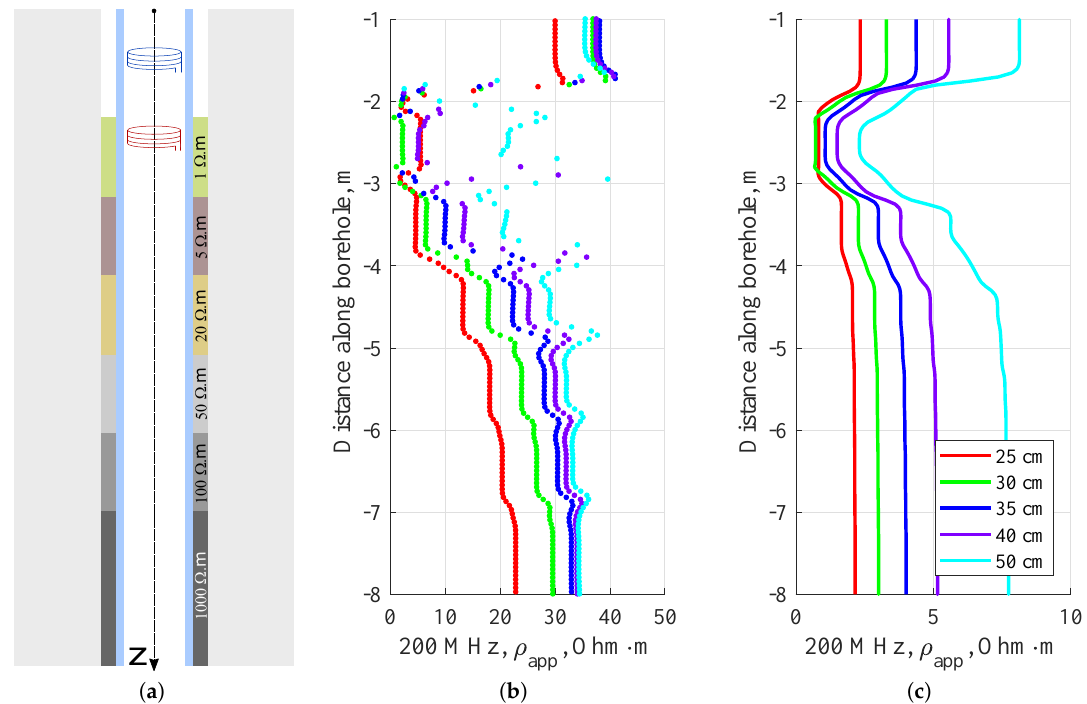
Figure 11. ( a ) The wellbore model with different resistivities of the cement (different solidification states) and apparent resistivity at the frequency of 200 MHz calculated from ( b ) signal phase and ( c ) amplitude. Different tool lengths are